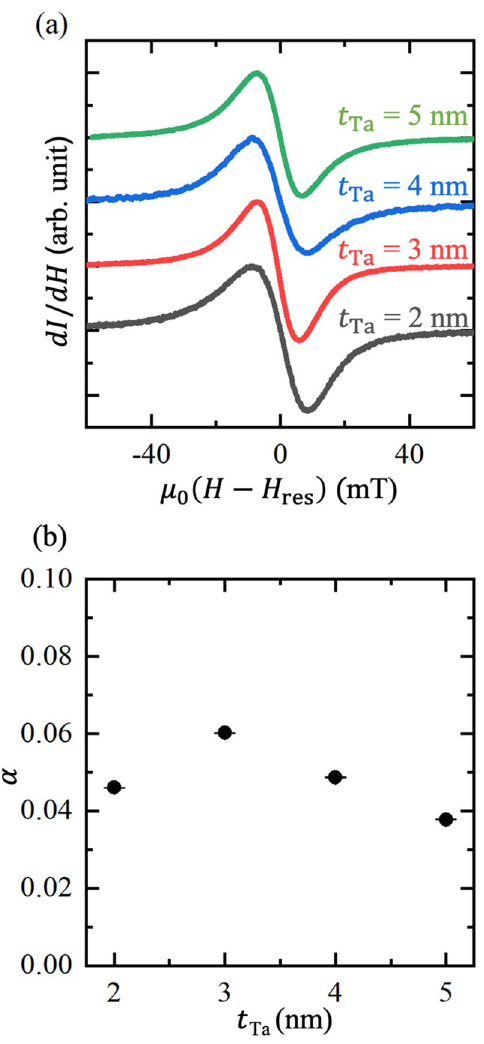
Figure 3. ( a ) FMR spectra from the Co (1 nm)/Ta ( t Ta nm) samples. The thickness of the Ta ( t Ta ) was changed from 2 to 5 nm. ( b ) The Ta thickness dependence of the Gilbert damping constant α